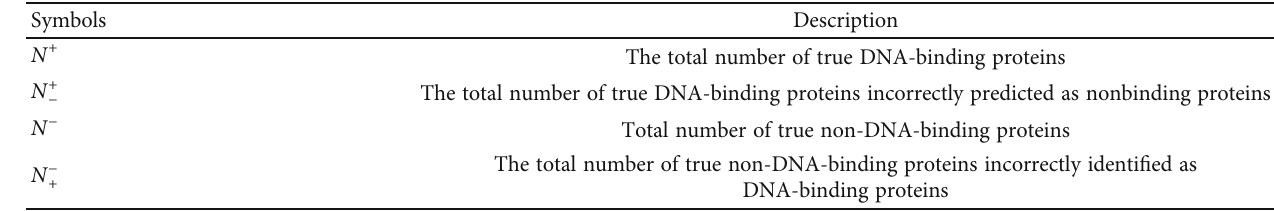
Figure 5: Arti fi cial neural networks working representation. Table 2: Description of equation symbols.